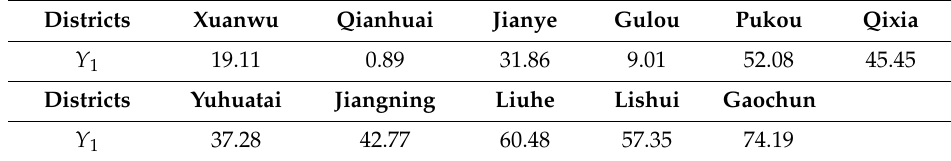
Table 5. Risk classification of Y 1 composite index of urban rainstorm risk in Nanjing cities in 2008.